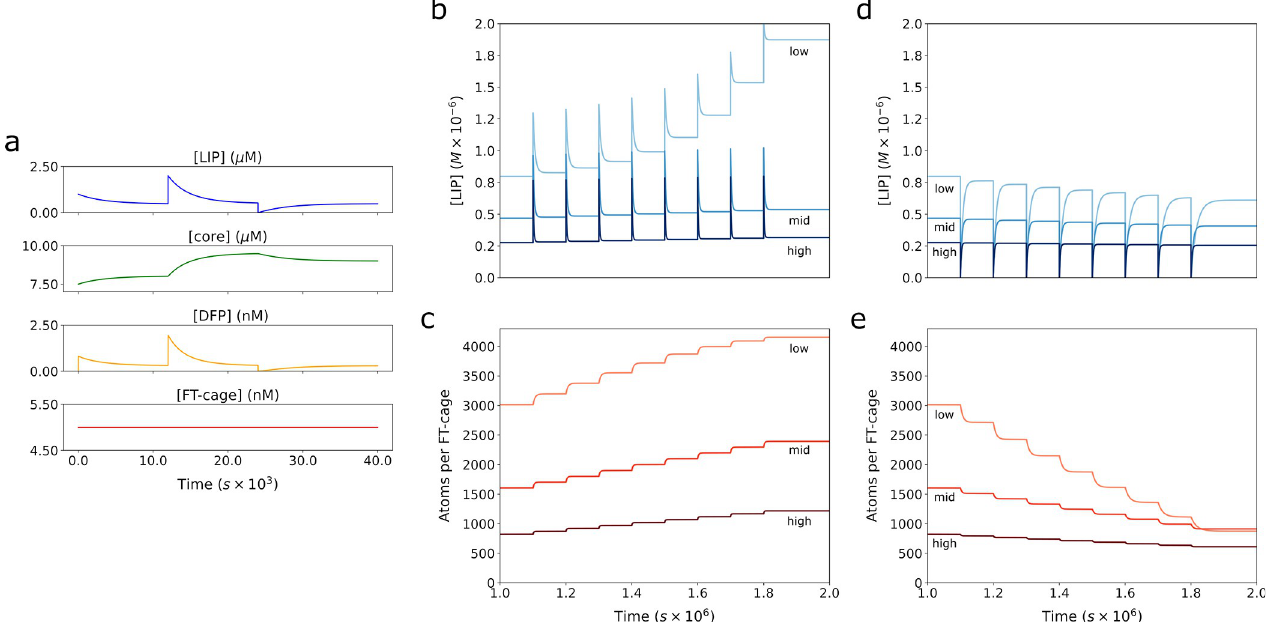
Fig 8. Model dynamics with FT core iron release. Release was incorporated into the model and balanced by expression as noted above to reach an equilibrium FT concentration of 5nM. The model was then run for 10,000 seconds to let the system approach steady state (where LIP did not change over time). Then LIP was doubled and subsequently halved (at time 25,000). a. The amount of LIP (blue), core (green), DFP (orange) and FT-cage (red) concentrations are plotted over time. For analyzing behavior over the long term and response to repeated iron challenges ( b — e ), three increasing expression rate values (3.075x10 -14 , 6.015x10 -14 , 1.203x10 -13 ) were chosen for the long term sequestration analysis (“low”, “mid”, “high” curve labels respectively). These rates corresponded to equilibrium concentrations of FT of 2.56nM, 5nM, and 10nM. For simulation every 10 5 s (about 1 day) the LIP was increased by 0.5 μ M, a small physiologic dose. The b ) LIP and c ) APC were plotted corresponding to the model with each of these expression rate values over time. The reverse was also performed, where every 10 5 s the LIP was reduced to 0 and again the d ) LIP and e ) APC were plotted.